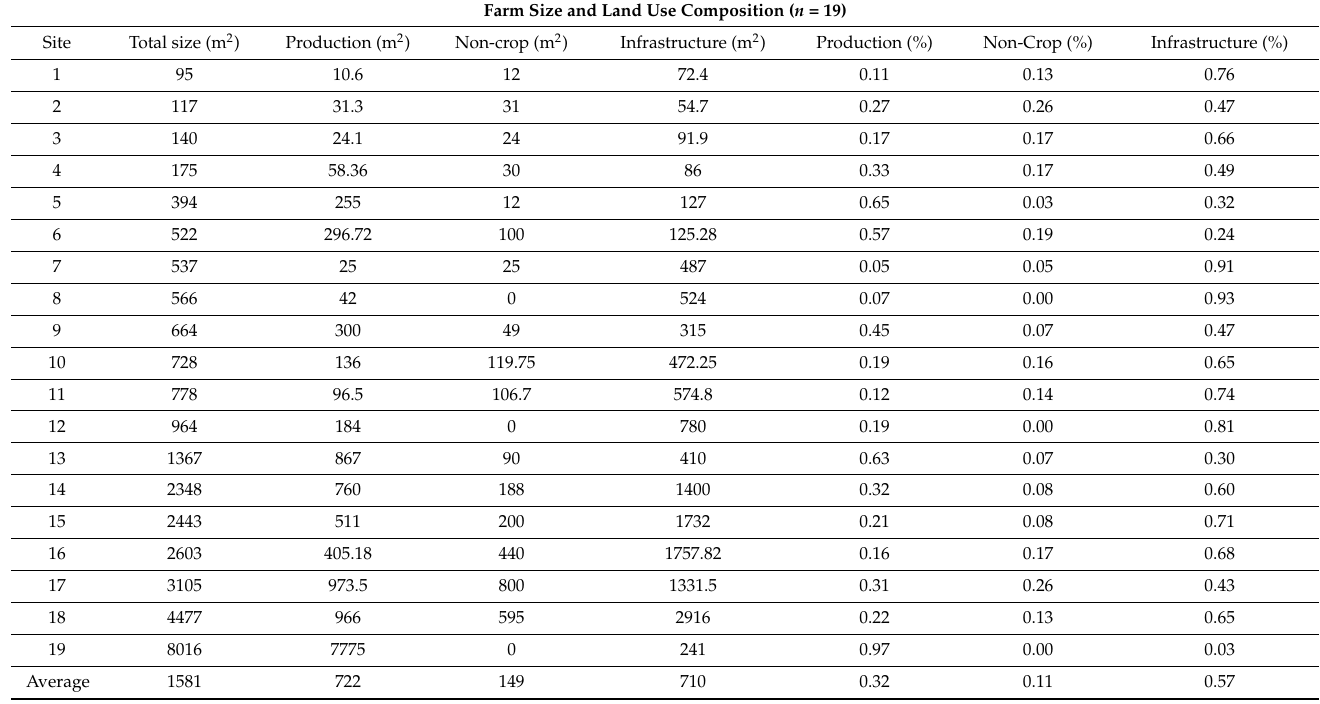
Table 1. Farm size and land use